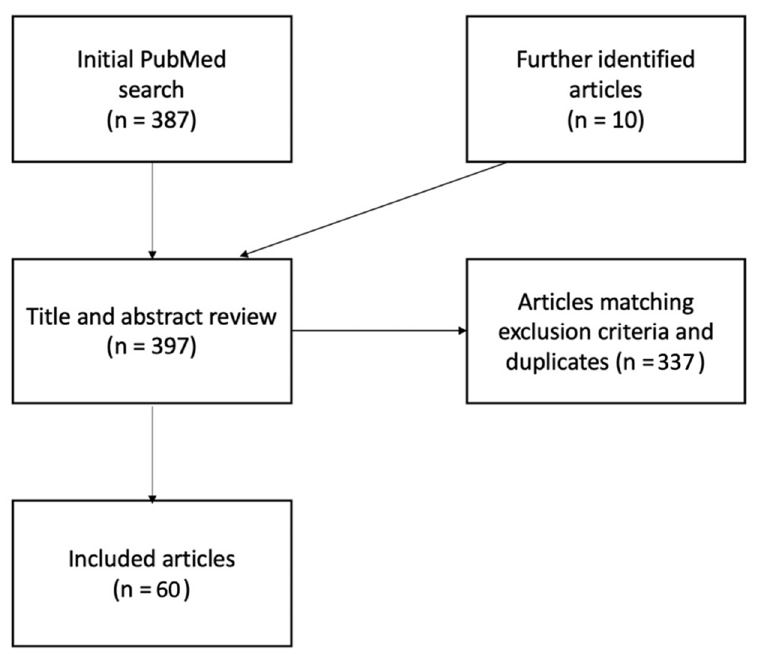
Figure 2. Pathway of articles identification, exclusion and Figure 2 . Pathway of articles identification, exclusion and inclusion.